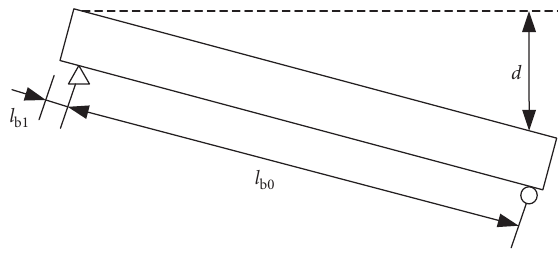
Figure 3: Bridge deformation.